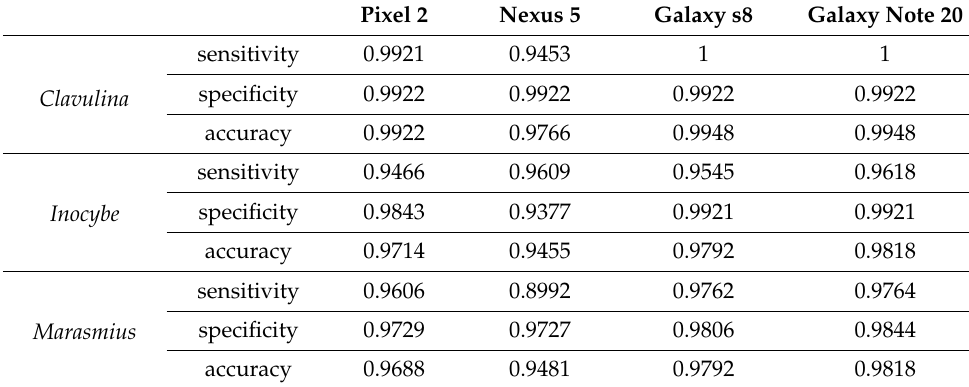
Table 3. Inter-phone testing results—3 classes.